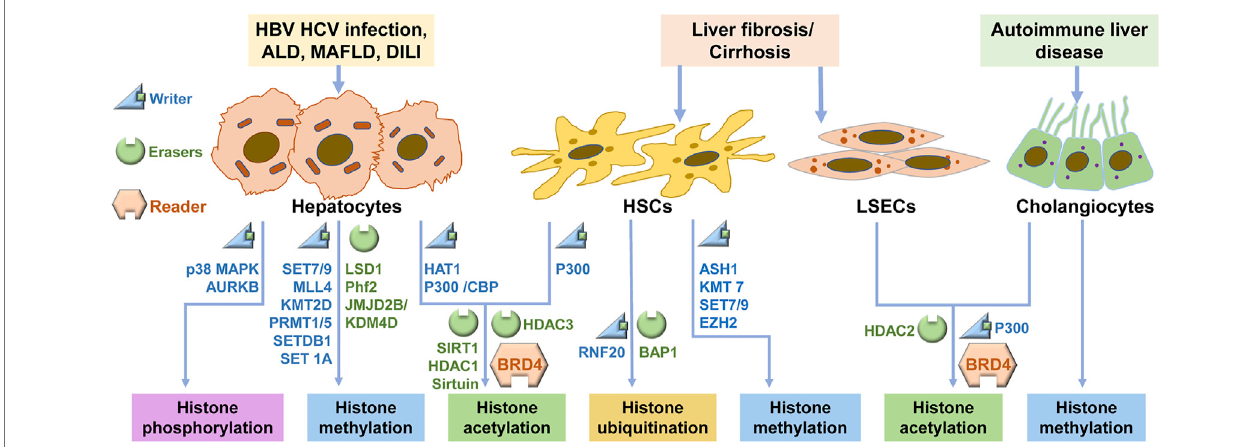
FIGURE 2 | Signaling regulations of histone modi fi cation in CLDs. In CLD, hepatocytes, HSCs, LSECs and cholangiocytes undergo histone modi fi cations via the regulation of the writers and erasers, and these modi fi cations are recognized by readers. ALD: alcoholic liver disease; MAFLD: metabolic-associated fatty liver disease; DILI: Drug-induced liver injury; HSC: hepatic stellate cell; LSEC: liver sinusoidal endothelial cell.